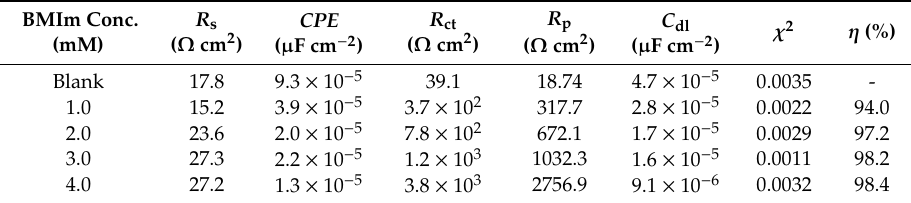
Table 3. EIS data for the corrosion of AA 6061 alloy in 1 M HCl in the existence of di ff erent concentration of inhibitor at 303